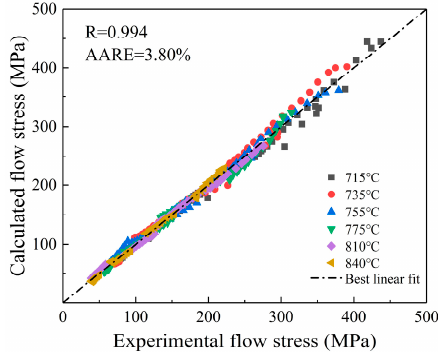
Figure 7. Correlations between experimental and model calculated flow stress.